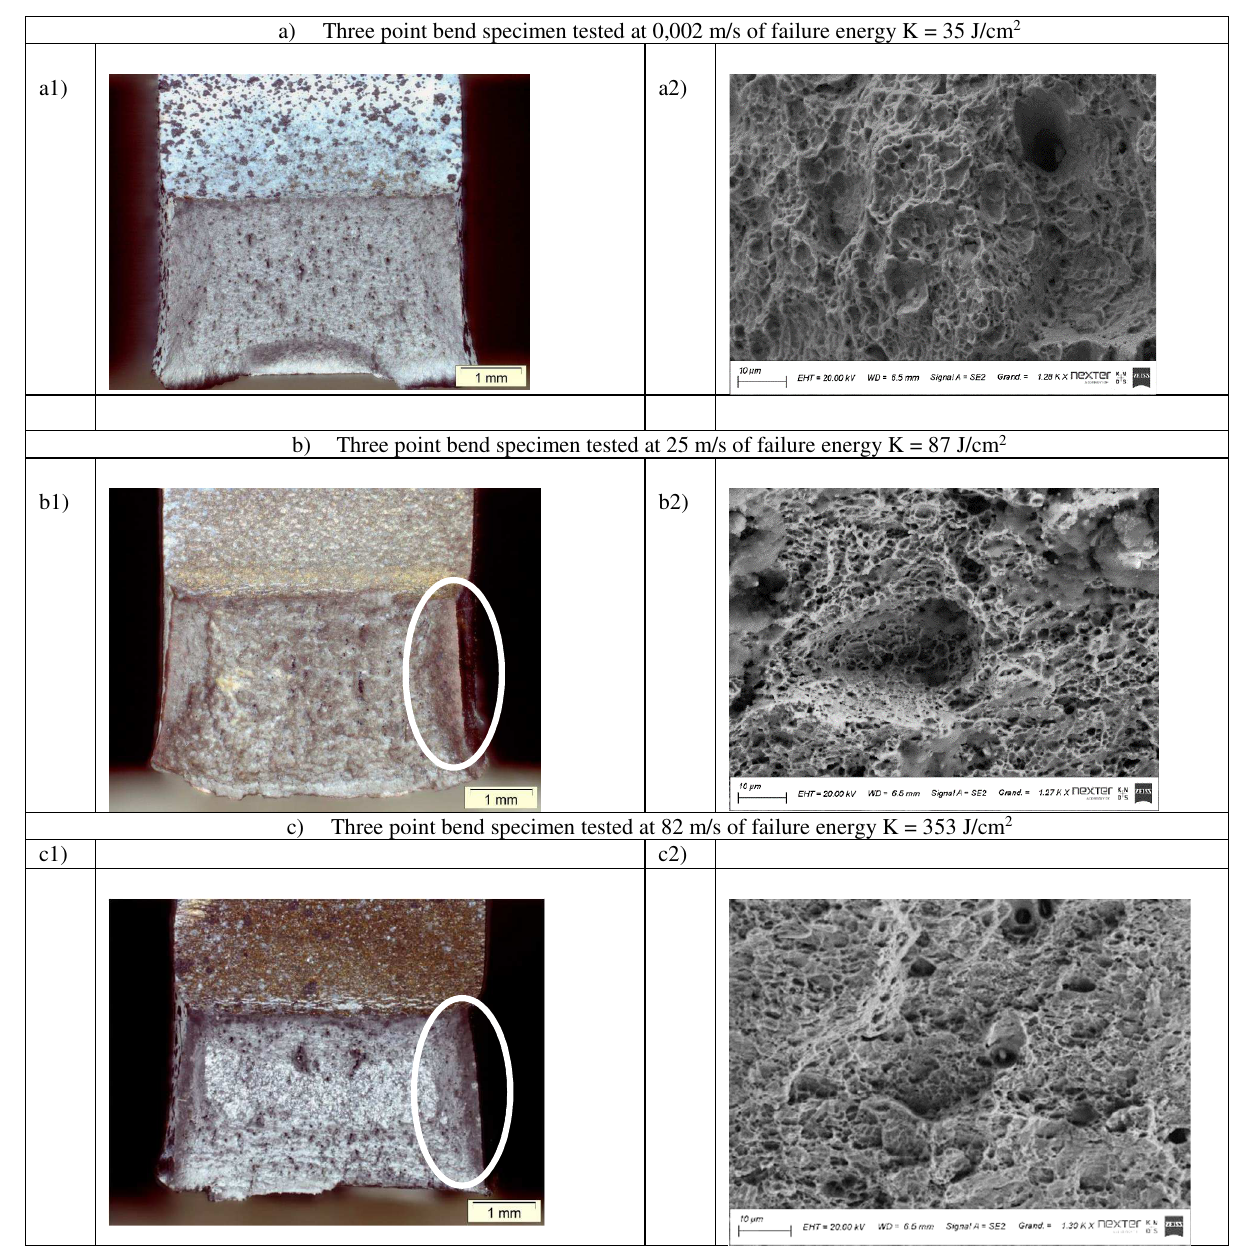
Fig. 7. Optical and microscopic observations of the fracture specimens tested under a) quasi-static conditions (V = 0.002 m/s), b) impact speed of 25 m/s, and c) impact speed of 80 m/s. The shear lips observed at the impact velocities of 25 and 80 m/s are